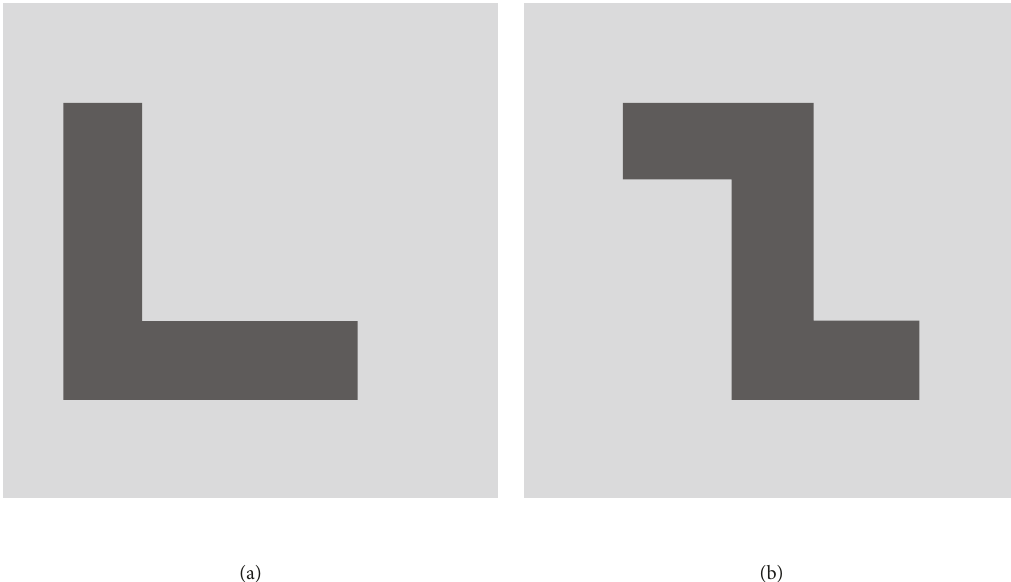
Figure 2: Single layer unit cells ( 0 43 λ